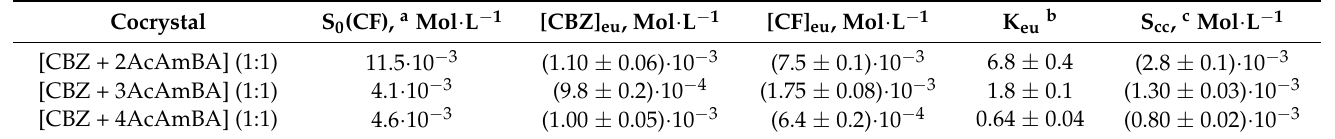
Table 3. Experimental values of the intrinsic solubility of coformers (S 0 (CF)), eutectic concentrations of CBZ ([CBZ] eu ) and coformers ([CF] eu ), calculated values of the eutectic constant (K eu ), and the solubility of the cocrystals at pH 2.0 and 310.2